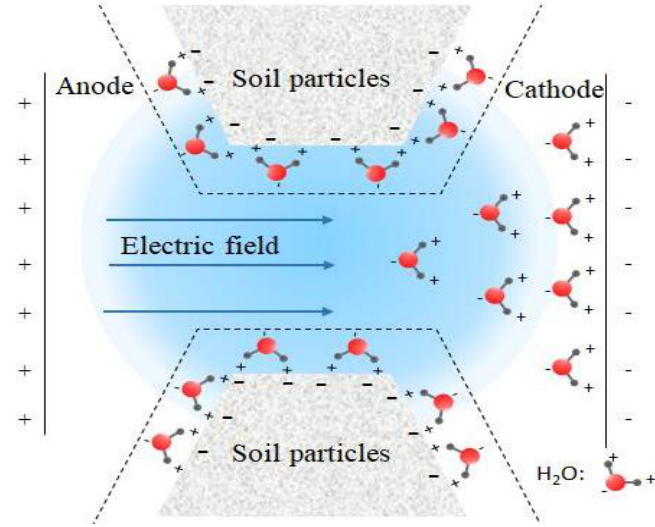
Figure 3. Electroosmosis principle of soft soil.